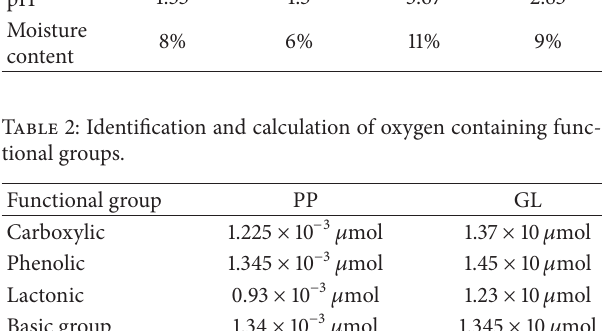
Figure 1: Structural formula of Brilliant Green.